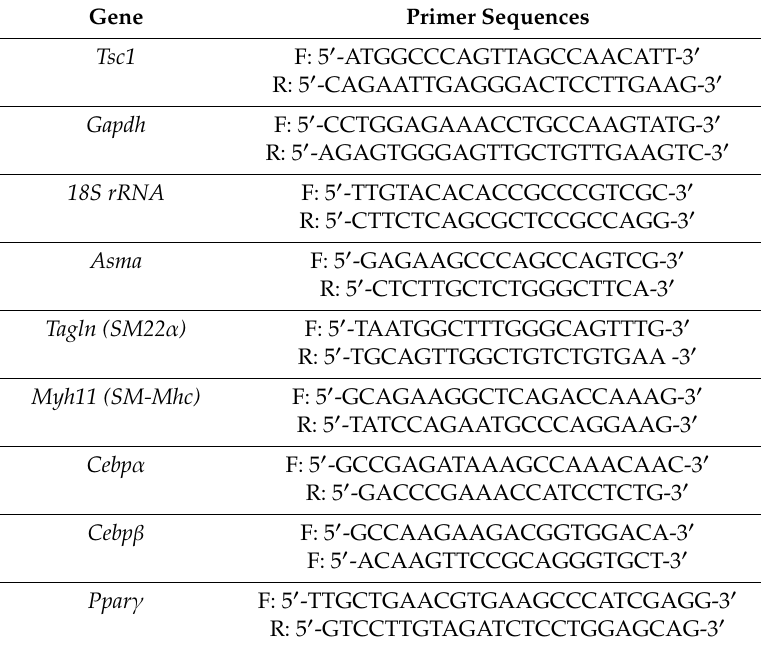
Table 1. Mouse primer sequences for